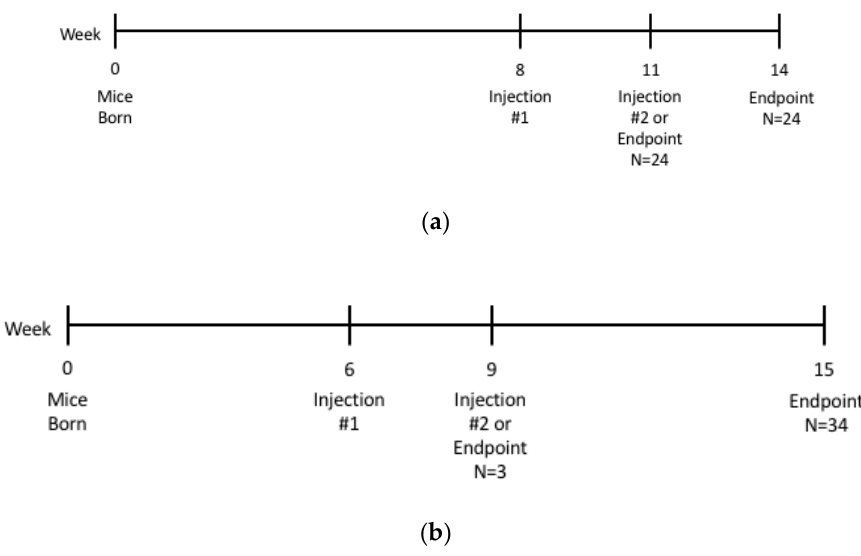
Figure 8. Study timeline in weeks of (a) TSD study and (b) SD study. ( a ) TSD mice were given the first injection at 8 weeks of age, and the second injection at 11 weeks of age. Mice were euthanized either at 11 weeks ( n = 24) or at 14 weeks ( n = 24). ( b ) SD mice were given their first injection at 6 weeks of age and their second injection at 9 weeks of age. Mice were euthanized at 9 weeks ( n = 3) or at 15 weeks ( n = 34).